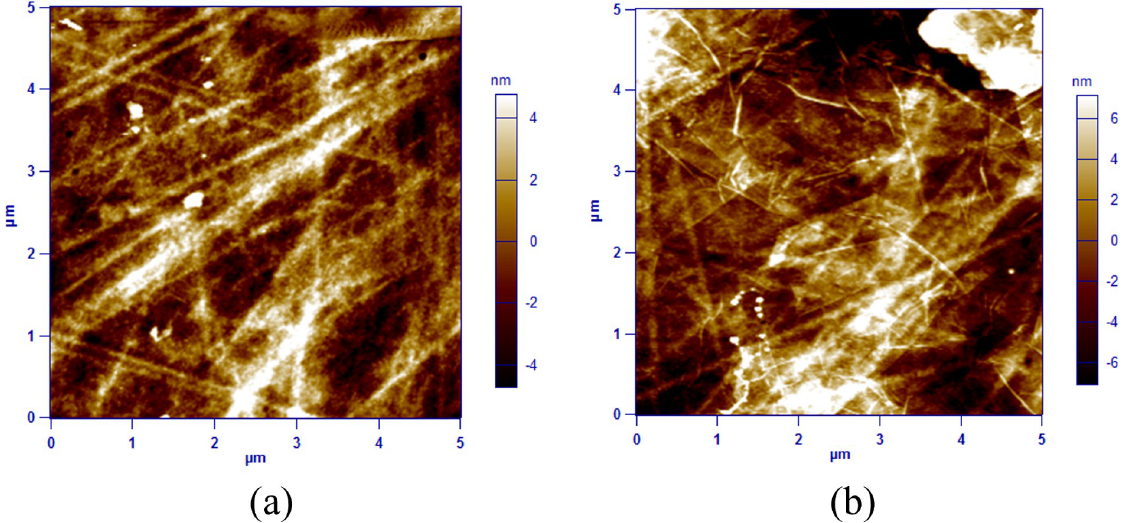
Fig 4. The AFM images for (a) COC plasma-treated surface and (b) GO-coated COC surface.